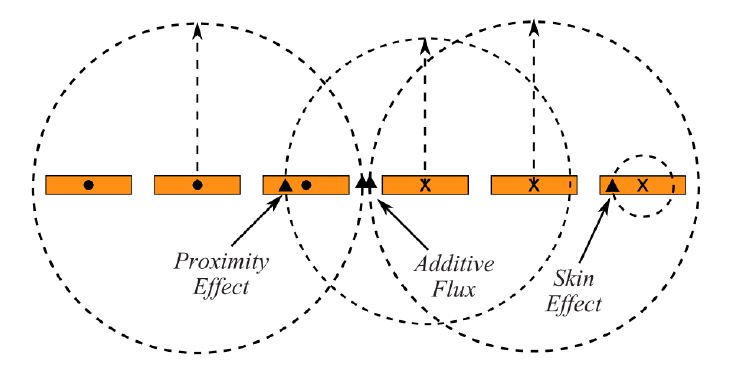
Figure 15. Idealized flux lines in a 3-turn planar spiral winding demonstrate the skin effects, proximity effects, and additive flux in the center of the winding. The direction of the current is shown by the dot and cross notation [58].